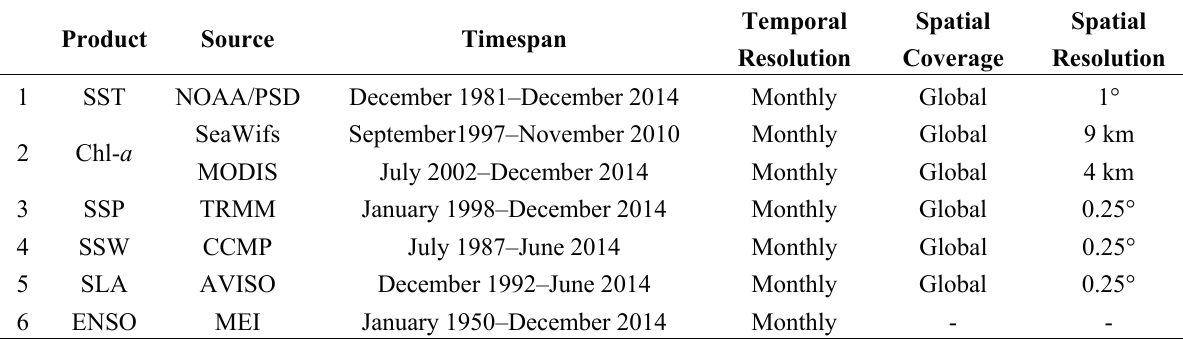
Table 1. Sources and resolution of remote sensing imagery used in the case study.